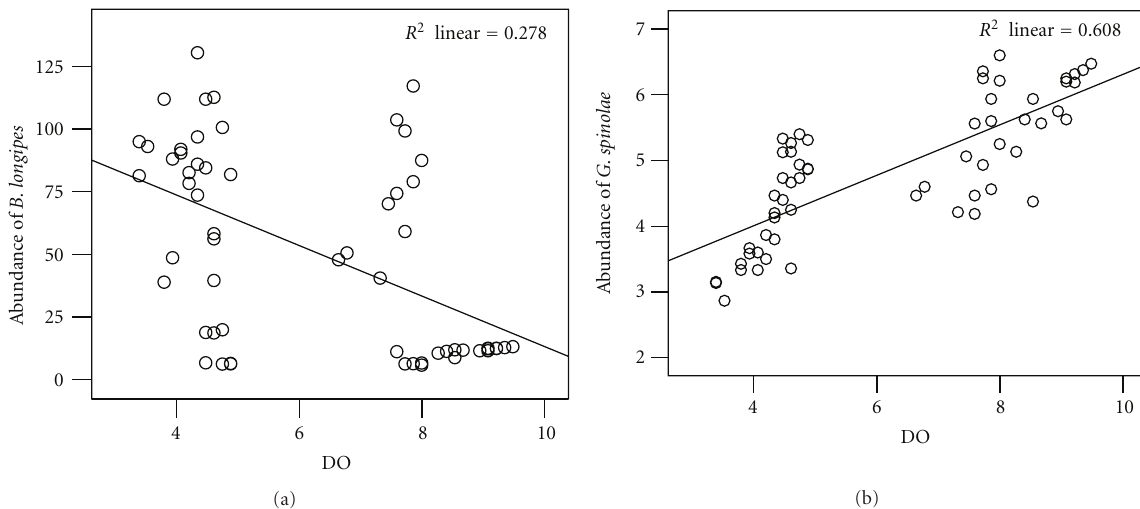
Figure 4: Relation between DO and abundance of (a) Brachydeutera longipes (Hendel) and (b) Gerris spinolae (Lethierry and Severin) as shown by regression analysis.